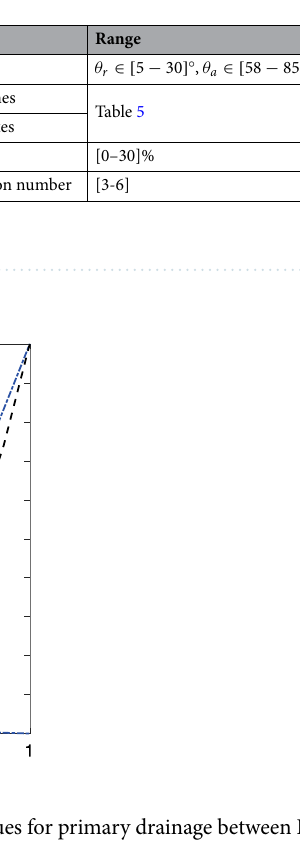
Figure 5. Benchmarking H 2 -brine relative permeability values for primary drainage between PNM and Corey functions with exponents that were used in the literature 30